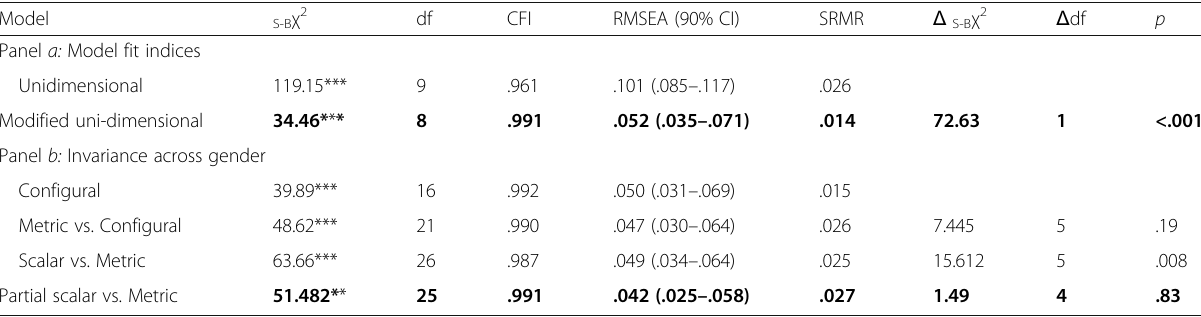
Table 2 Fit indices (panel a) and model comparisons for gender invariance of ESSI (panel b) Model S-B χ 2 df CFI RMSEA (90% CI) Panel a: Model fit indices Unidimensional Modified uni-dimensional Panel b: Invariance across gender Configural 39.89*** .015 Metric vs. Configural 48.62*** Scalar vs.